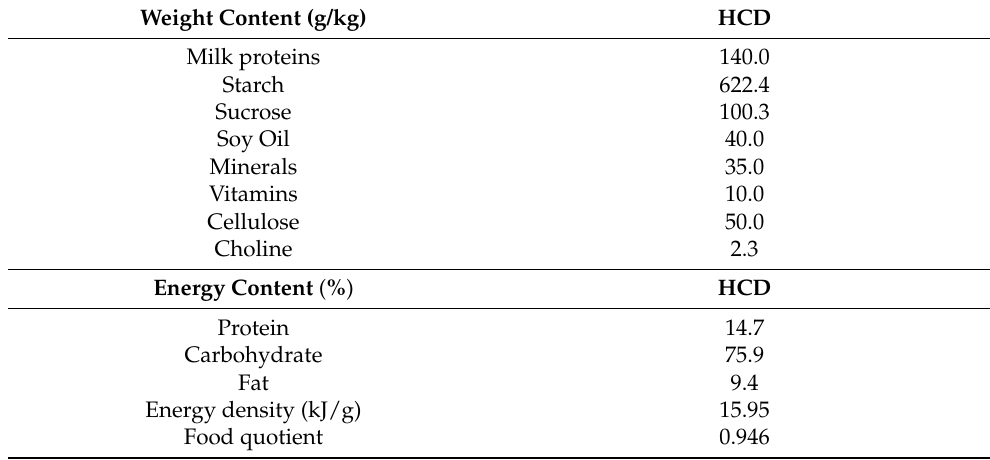
Table 2. Macronutrient composition of high-carbohydrate diet